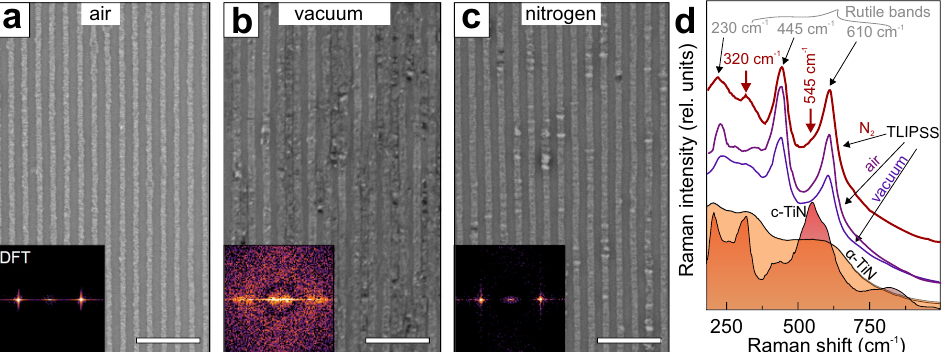
Figure 4. ( a – c ) SEM images of the TLIPSS formed on the surface of 180-nm thick Ti film in air ( a ), vacuum ( b ) and nitrogen-rich atmosphere ( c ). Fixed laser-processing conditions were used for TLIPSS fabrication: f = 200 kHz, F = 70 mJ/cm 2 , v = 1 µm/s. Scale bar indicates 4 µm. Insets show DFT images taken from the corresponding SEM images. ( d ) Averaged Raman spectrum of the TLIPSS produced in the nitrogen-rich atmosphere (red curve), air (purple curve) and vacuum (blue curve). Raman spectra of amorphous and crystalline TiN are provided for comparison. Characteristic bands associated with TiO 2 (rutile) and TiN are also